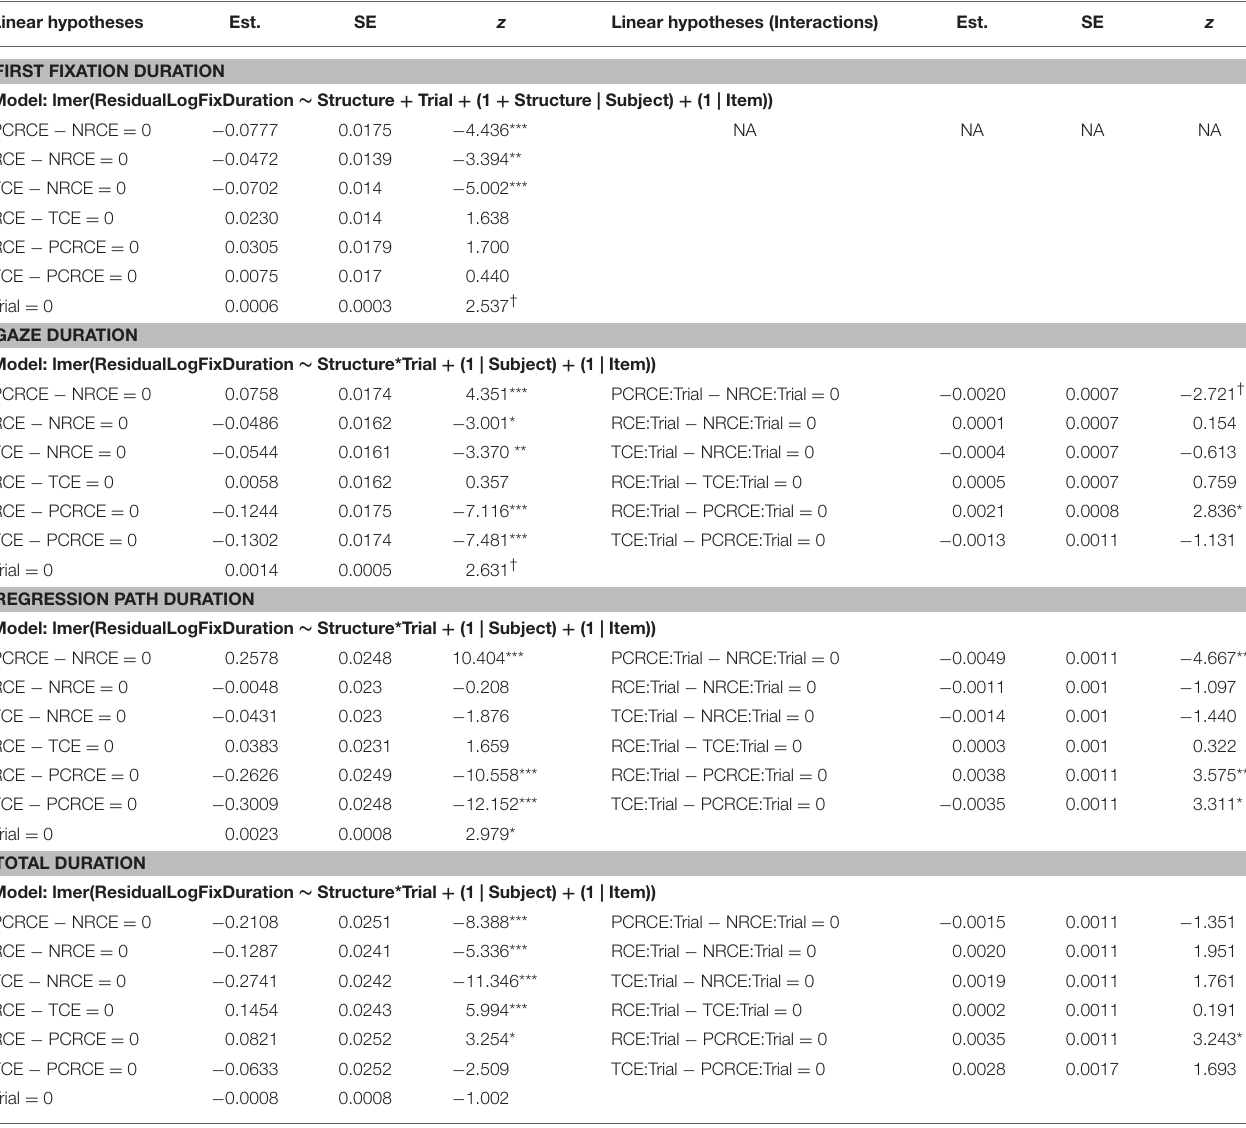
TABLE 4 | Experiment 1 R01 (First embedded verb): Simultaneous tests for general linear hypotheses for linear effects models fitted to log-transformed and residualized fixation durations. Linear